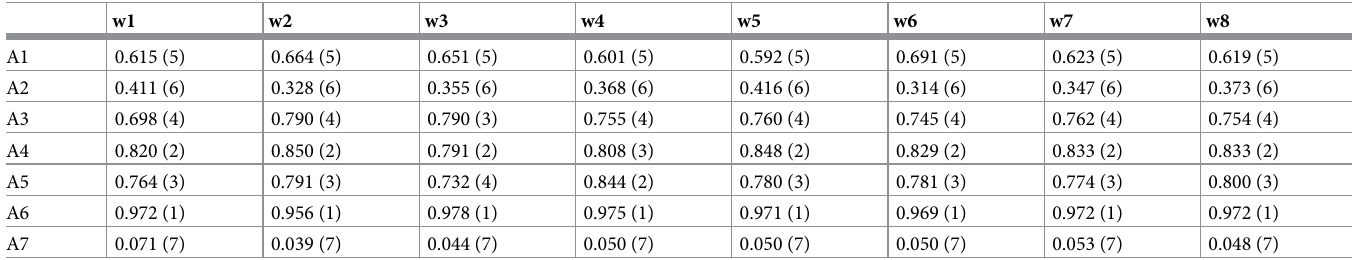
Table 9. Appraisal scores and final rankings of candidates for different criterion weight distribution scenarios.